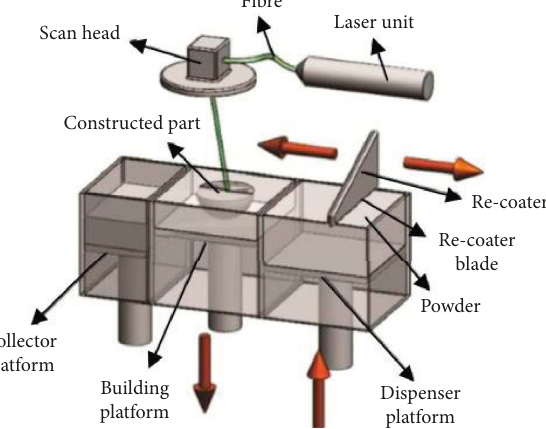
Figure 1: Schematic representation of DMLS